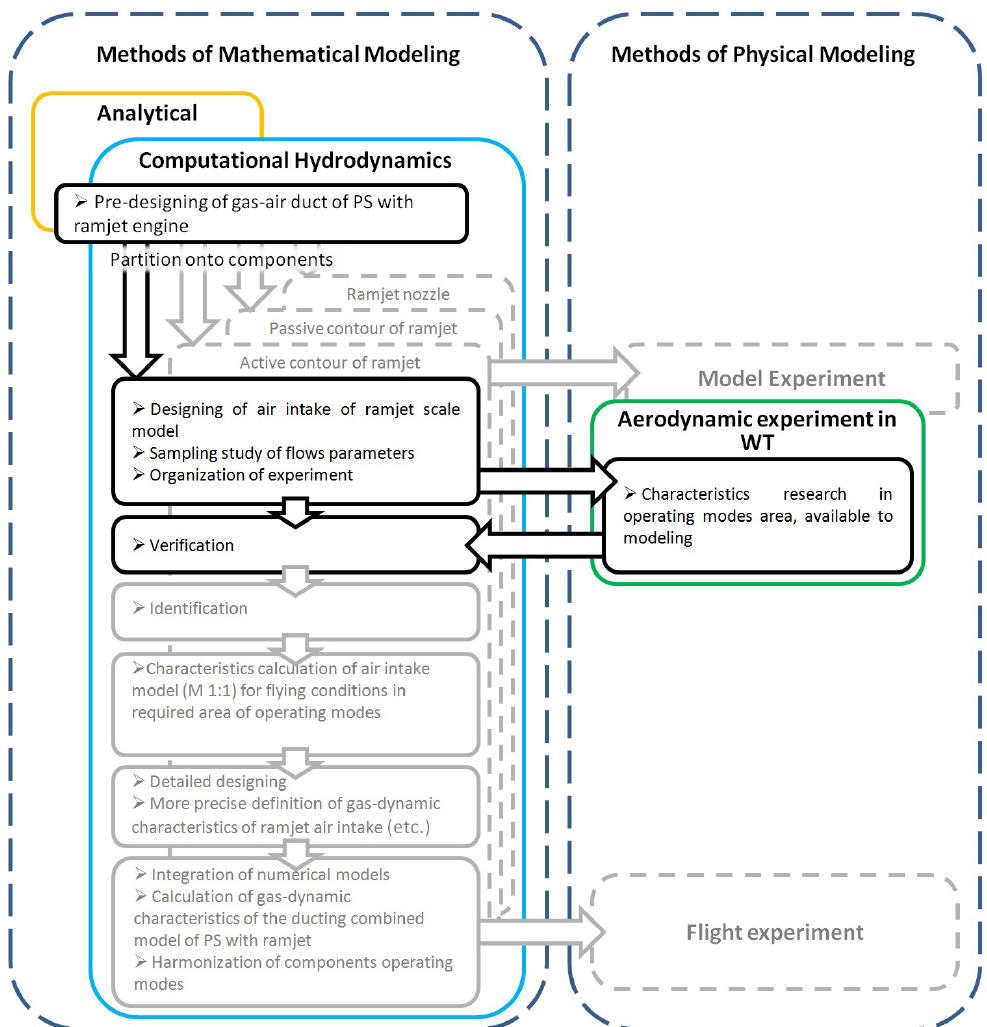
Figure 1. Architecture of the steps for designing sthe supersonic air intake of the ramjet engine (the considered phases are